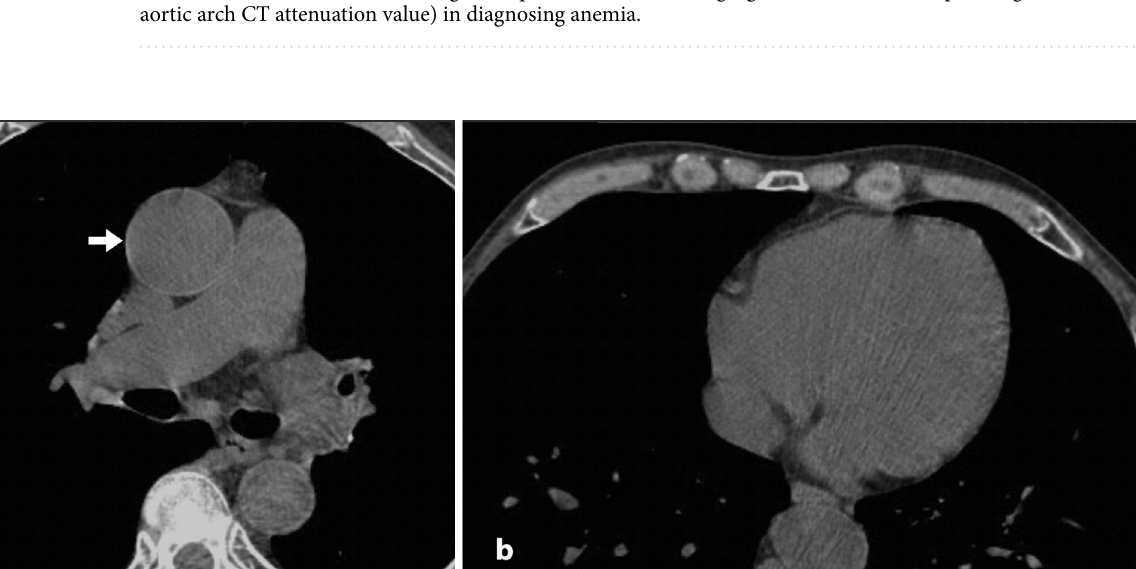
Figure 4. In this 74 y/o man with mild anemia, aortic ring sign is present (arrow in ( a )), but there is no interventricular septal sign ( b